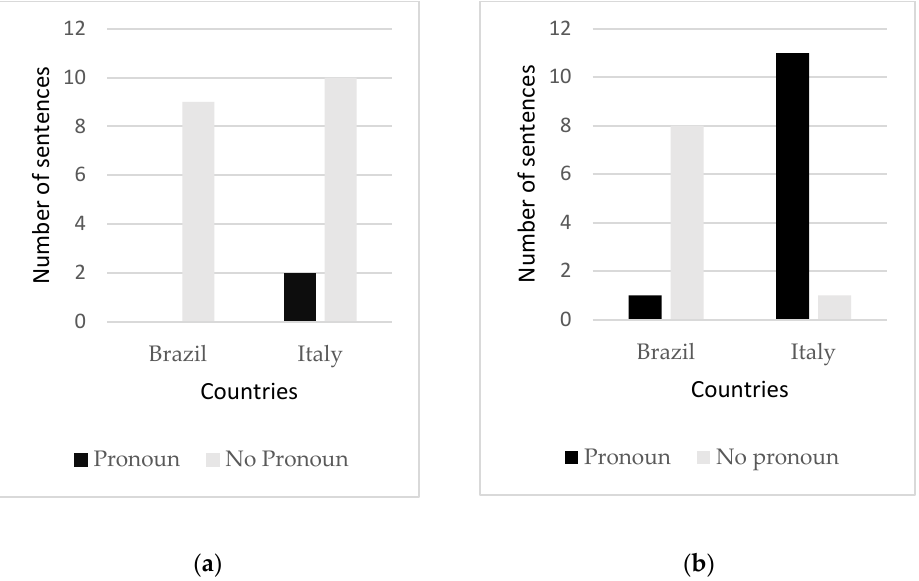
Figure 1. Realisation of resumptive pronouns in relative clauses in Brazilian and Italian Venetan; restrictive ( a ) and appositive ( b ) relative clauses. Number of informants: Italian Venetan, n = 4; Brazilian Venetan, n = 3. Number of tested items: 6 (3 restrictive relative clauses, 3 appositive relative clauses). Sentences analysed in total: Italian Venetan, n = 24 (12 appositive relative clauses, 12 restrictive relative clauses); Brazilian Venetan, n = 18 (9 appositive relative clauses, 9 restrictive relative clauses).